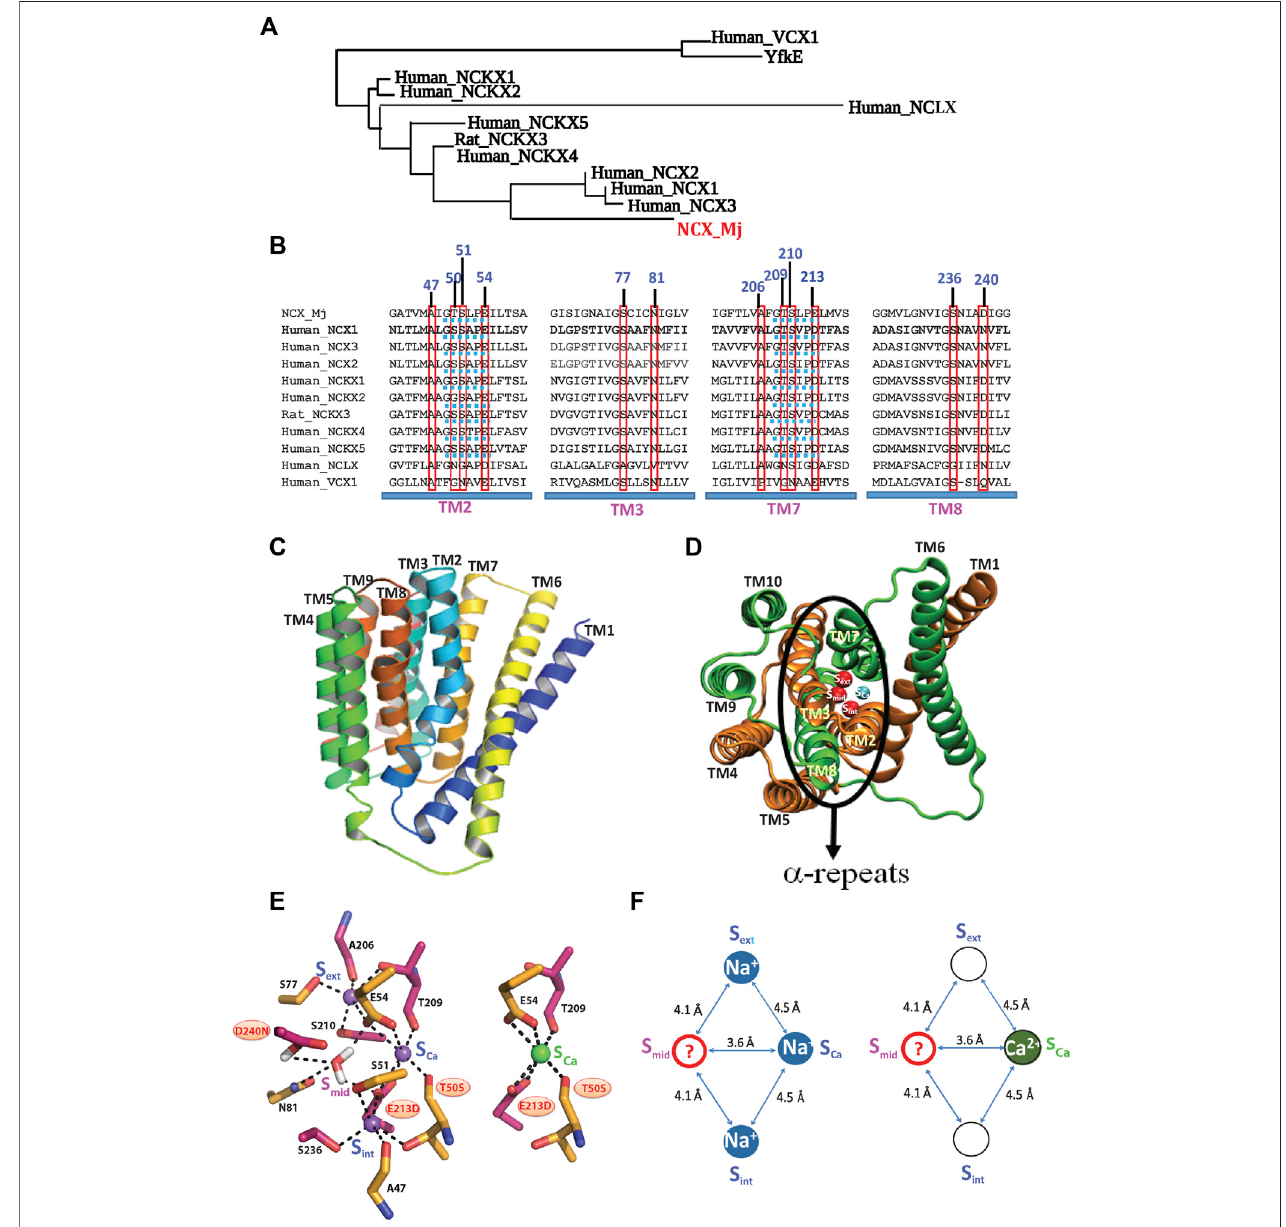
FIGURE1| TopologicalandstructuralhighlightssharedbytheCa2+/CAproteins. (A) Thephylogeneticallyrelatedgenefamilies,belongingtothesuperfamilyofthe Ca 2+ /CA antiporters, share a common topology and structural motifs with inverted twofold symmetry, highly conserved α -repeats and ion-coordinating residues. The underlyingstructure-functionrelationshipsareofgeneralinterest,sincethedifferentgeneproductscanselectivelyrecognizeandtransportdistinctmonovalentions(Na + , K + , H + , and/or Li + ) in exchange with Ca 2+ . (B) Sequence alignments of the NCX, NCKX, NCLX, and CAX proteins (belonging to the superfamily of the Ca 2+ /CA antiporters) contain ion-coordinating residues at four transmembrane helices (TM2, TM3, TM7, and TM8). The red boxes denote the residue overlays of twelve ion- coordinating residues in the Ca 2+ /CA proteins (the numerations of ion coordidinating residues are assigned according to NCX_Mj). Blue dotted lines denote the helix- breaking signiture sequences (similar to GTSPLE) in different Ca 2+ /CA proteins. (C) The crystal structure of outward-facing (OF) NCX_Mj (PDB 3V5U) depicts ten transmembrane helices(TM1-TM10). (D) Eight helices (TM2-5and TM7-10)form atightlypacked hub(that isperpendicularlyinsertedintothemembrane),whereastwo longandtiltedhelices(TM1andTM6)arelimplypackedinfrontofarigideight-helixcore. (E) Twelveion-coordinatingresiduesformfourbindingsites(S int ,S mid ,S ext ,and S Ca ). (F) NCX_Mj can alternatively bind either 3Na + (at S int , S Ca , and S ext ) or 1 Ca 2+ (S Ca ). According to this model, the S Ca site binds either the Na + or Ca 2+ ion, whereas the S mid site can be occupied by a water molecule (through protonated D240), but not by Na + or Ca 2+ .